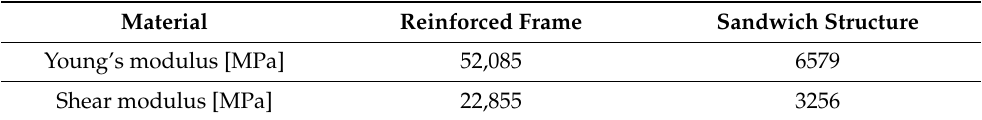
Table 11. Elastic constants computed for reinforced frame and honeycomb structure.